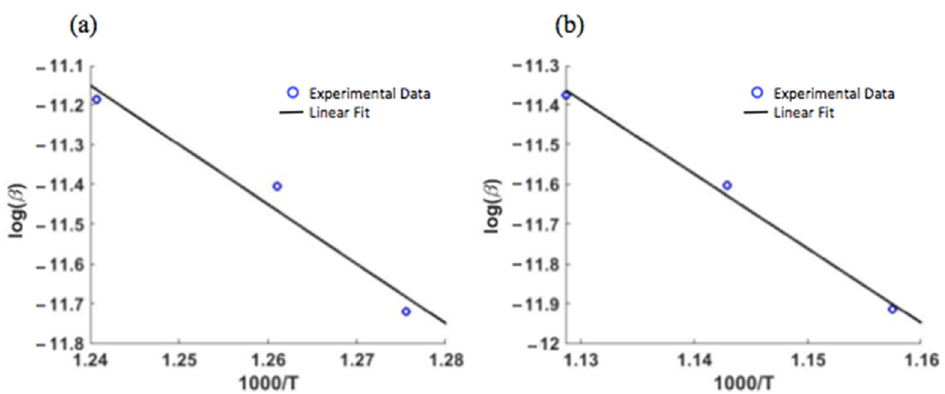
Figure 8. Flynn–Wall–Ozawa data line for ( a ) SWCNT samples and ( b ) MWCNT samples. Blue circles indicate dataset derived from the peak temperature of the DSC thermograph, and the black line is linear fit of the experimental data.